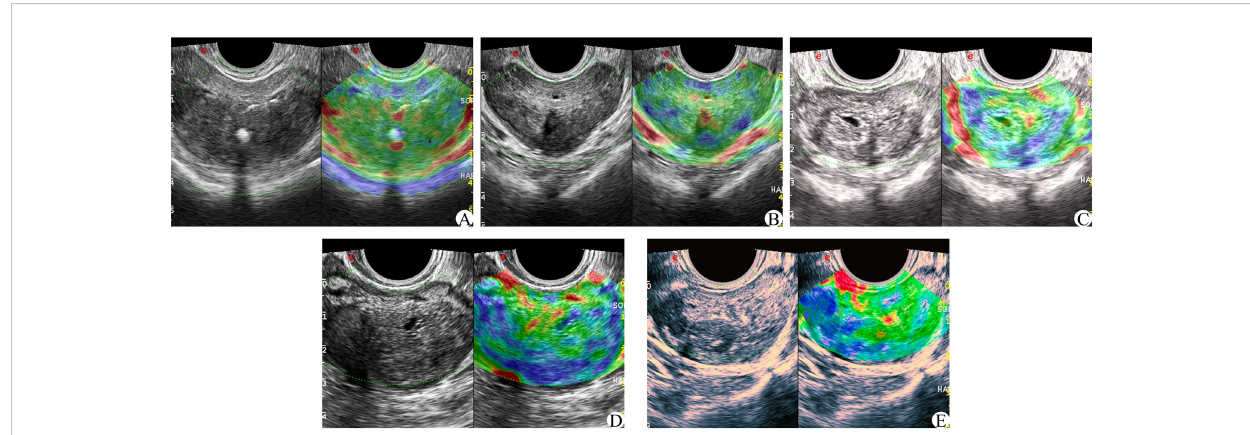
FIGURE 3 Zordo 5-point evaluation sample; (A) The whole prostate showed uniform green color at 1 point; (B) The whole gland is symmetrically distributed in blue and green phases. (C) 3 parts in the prostate with asymmetric distribution of texture hardening area; (D) 4 points of hypothetic nodules in the prostate, with hard central texture and soft peripheral texture; (E) Hypoechoic nodules in the prostate, and the whole nodules become hard in